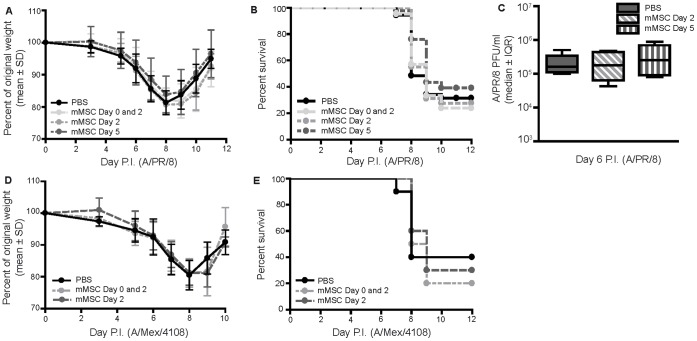
Neither prophylactic nor therapeutic administration of mMSCs affected weight loss or improved survival in two models of experimental severe influenza.7–10 week-old male C57Bl/6 mice were (A,B) infected with 425 EID50 influenza A/PR/8 virus and administered 2.5×105 mMSCs (passage 6–9), intravenously, either prophylactically (4 hours prior to infection and day 2 post-infection (P.I.)) or therapeutically (day 2 or day 5 P.I.). No significant differences in weight loss kinetics (Two-way ANOVA, n = 21–46/group, 3 pooled experiments) or survival (logrank test, n = 21–46/group, 3 pooled experiments) were observed. Error bars represent standard deviation. (C) Lungs were harvested on day 6 P.I. and viral load was quantified via plaque assay in MDCK cells. No significant differences were observed (one-way ANOVA, n = 5/group). Error bars represent interquartile range (IQR). PFU = plaque forming units. (D,E) Mice were infected with 1000 EID50 influenza A/Mex/4108 and administered mMSCs prophylactically (4 hours prior to infection and day 2 P.I.) or therapeutically (day 2 P.I.). No significant differences in weight loss kinetics (two-way ANOVA, n = 10/group) or survival (logrank test, n = 10/group) were observed. Error bars represent standard deviation.